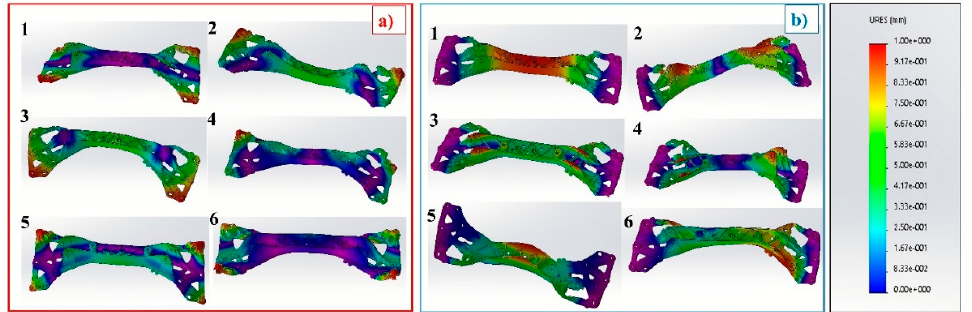
Figure 5. Displacement trend for the first six vibration modes for original geometry: ( a ) free-free boundary conditions and ( b ) fixed conditions.